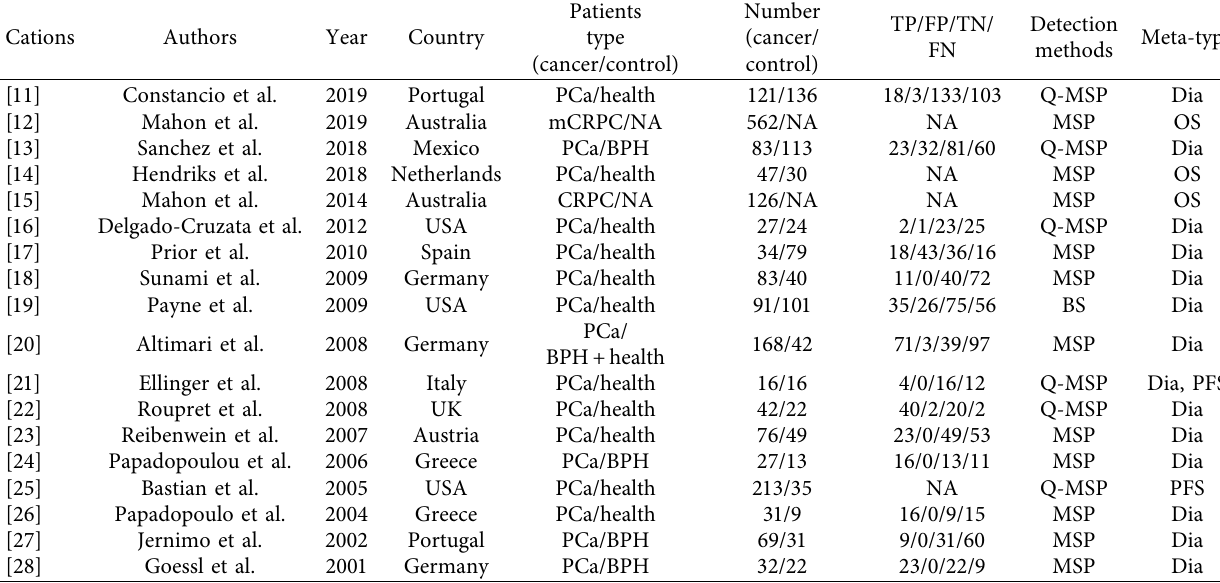
Table 1: Baseline characteristics of the 18 eligible articles.